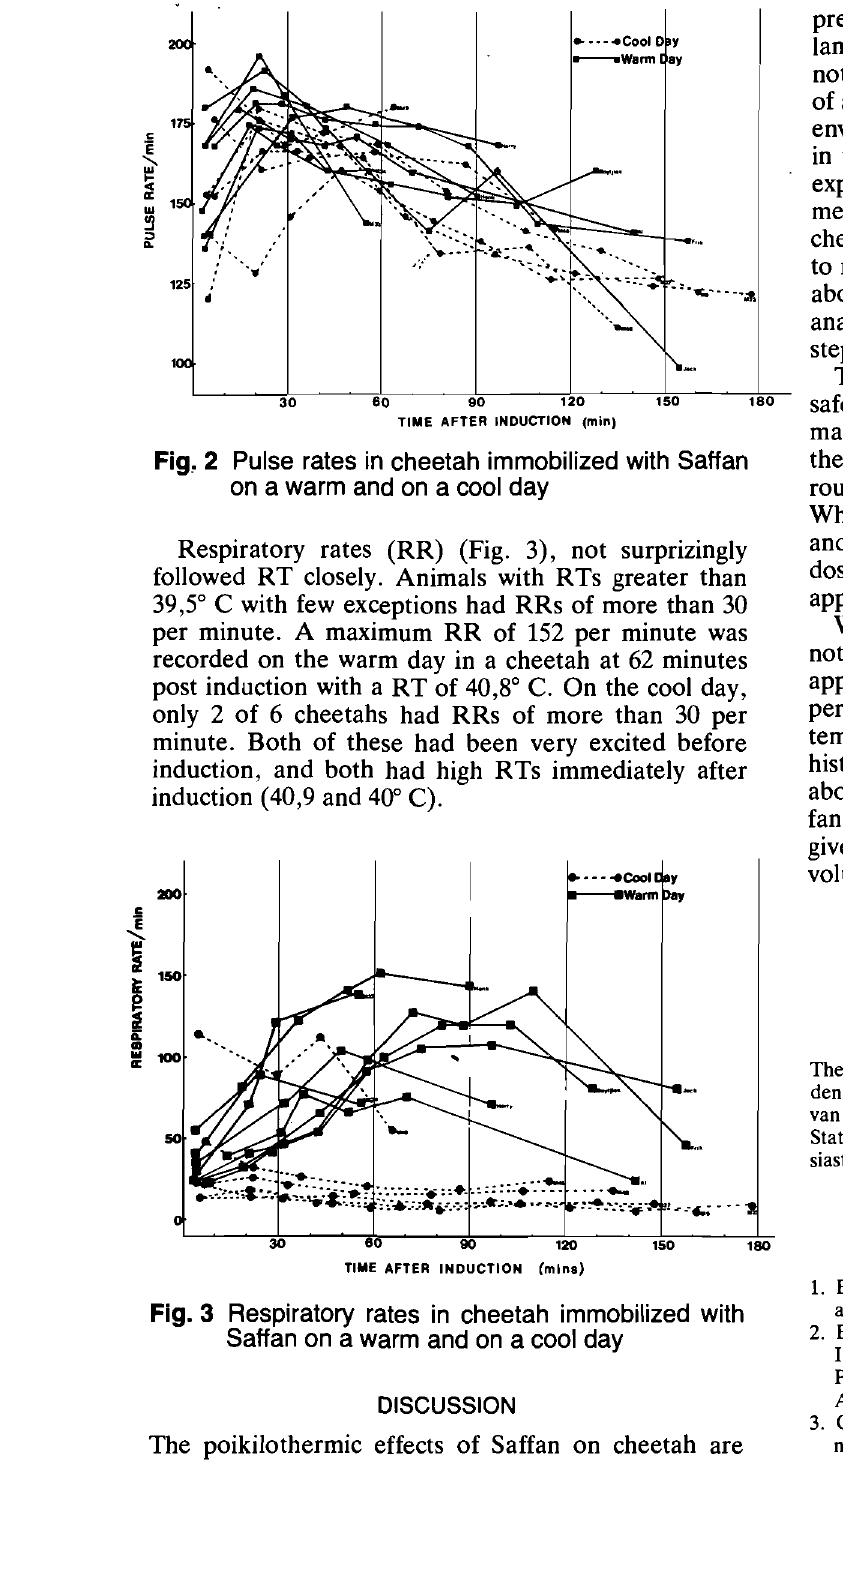
Fig. 3 Respiratory rates in cheetah immobilized with Saffan on a warm and on a cool day